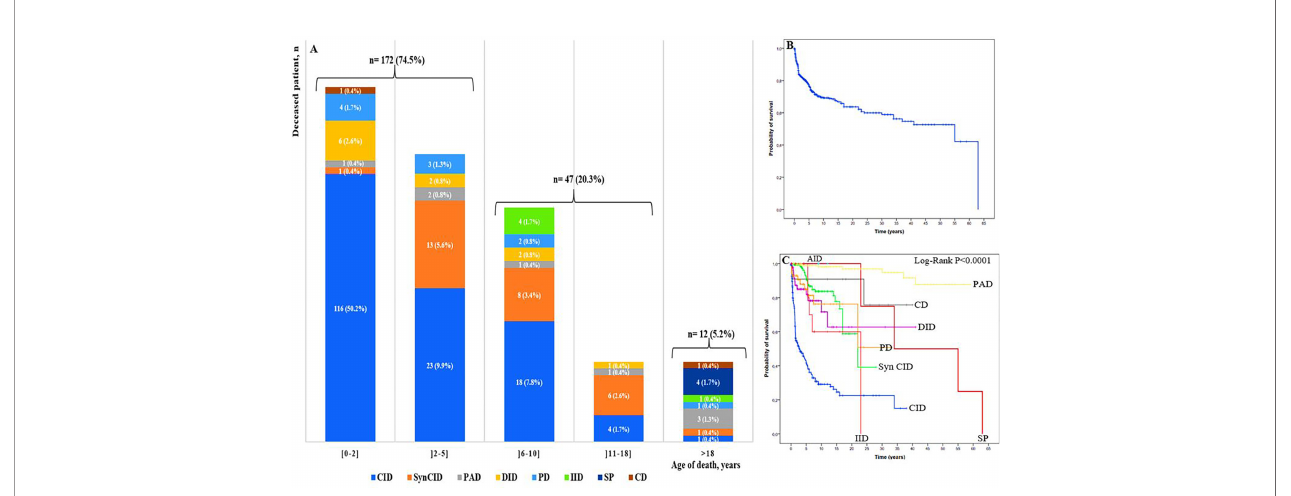
FIGURE 6 | (A) Mortality rate by PID group and age of the deceased patients (n: 231). Colors represent different IEI categories. Numbers in the plots show the number of patients and the ratio of the deceased patients by IEI group to the total number of the deceased patients of the age-group; (B) Overall survival (Kaplan- Meier curve) of patients with IEI showing the probability of survival following diagnosis. (C) Kaplan-Meier curve showing overall survival in the 807 studied patients within the 9 categories of IEI. CID, combined immunode fi ciencies; SyCID, syndromic combined immunode fi ciencies; PAD, predominantly antibody de fi ciencies; DID, Dysregulation of immune diseases; PD, phagocytic disorders; CD, complement de fi ciencies; IID, innate immune de fi ciencies; AID, autoin fl ammatory diseases; SP, Somatic